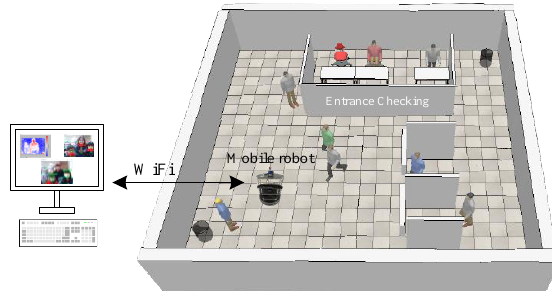
Figure 1. Scenario diagram.